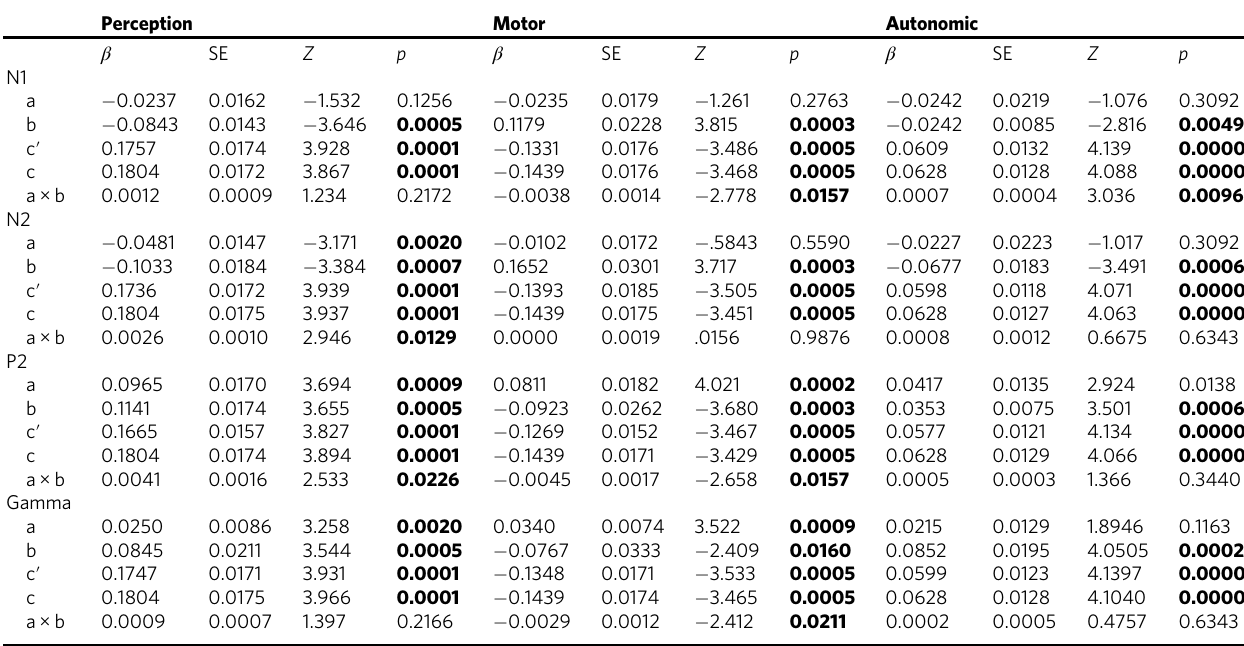
Table 2 Results of the two-path mediation analysis